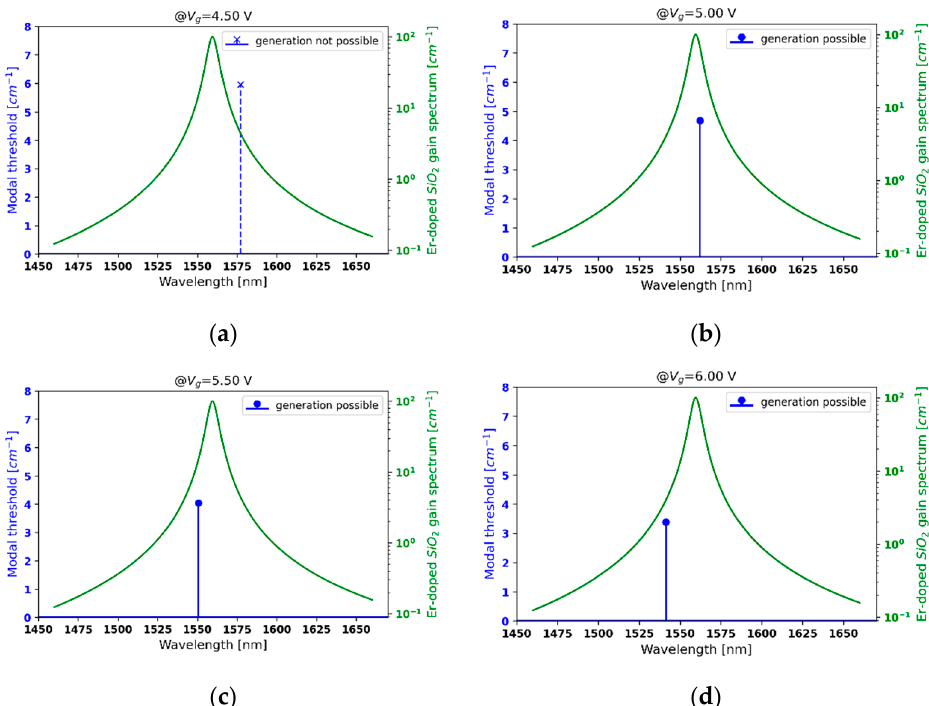
Figure 9. Threshold modal spectra for a PHC structures with HMM structures revealing type II hyperbolic dispersion and biased with external voltage V g = 4.5 V ( a ), 5.0 V ( b ), 5.5 V ( c ) and 6.0 V ( d ).